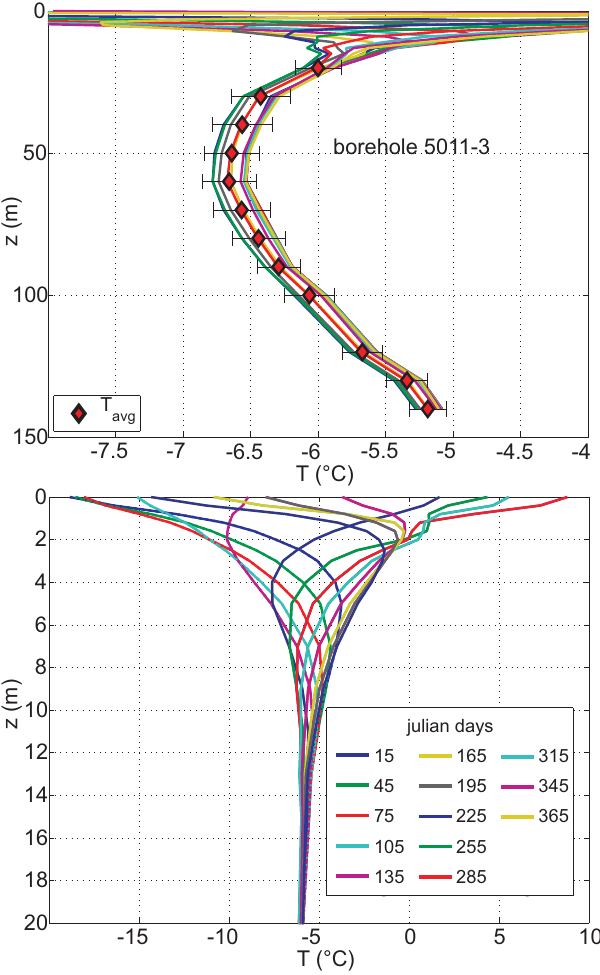
Fig. 3. Selection of the temperatures logs in the permafrost borehole 5011-3 during the year 2010. Note the different scales in the two panels.